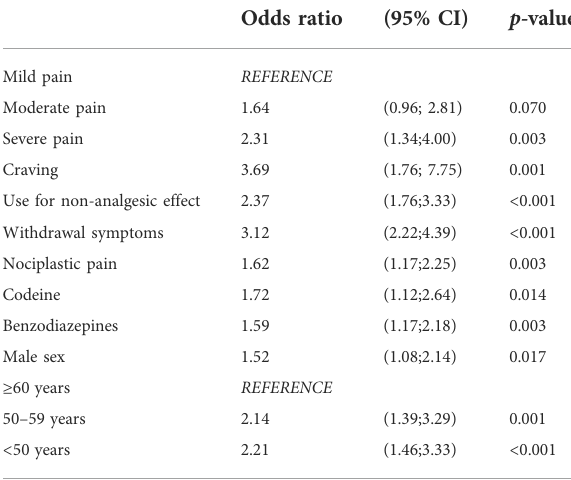
TABLE 3 Factors related to the presence of prescribed opioid misuse. Data are presented as Odds-ratios and 95% con fi dence interval